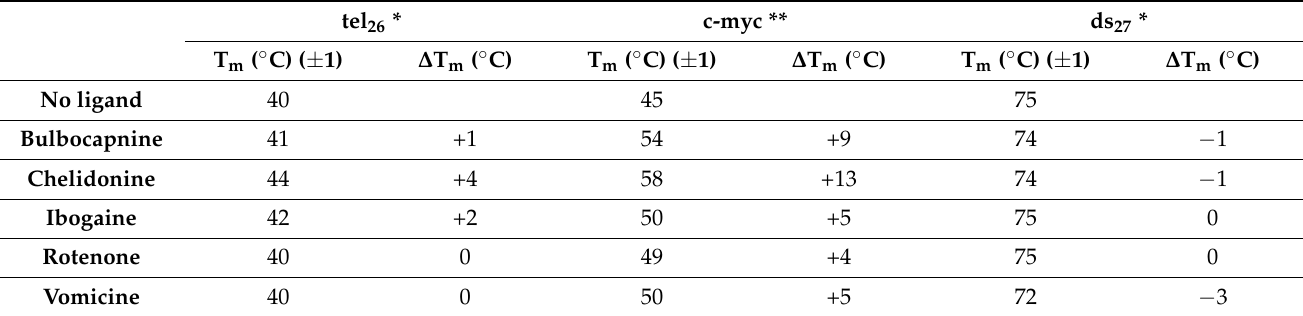
Table 2. Melting temperatures (T m ) of tel 26 and c-myc G4s or ds 27 duplex in the absence or presence of the ligands (10 molar equivalents) as measured by CD-melting